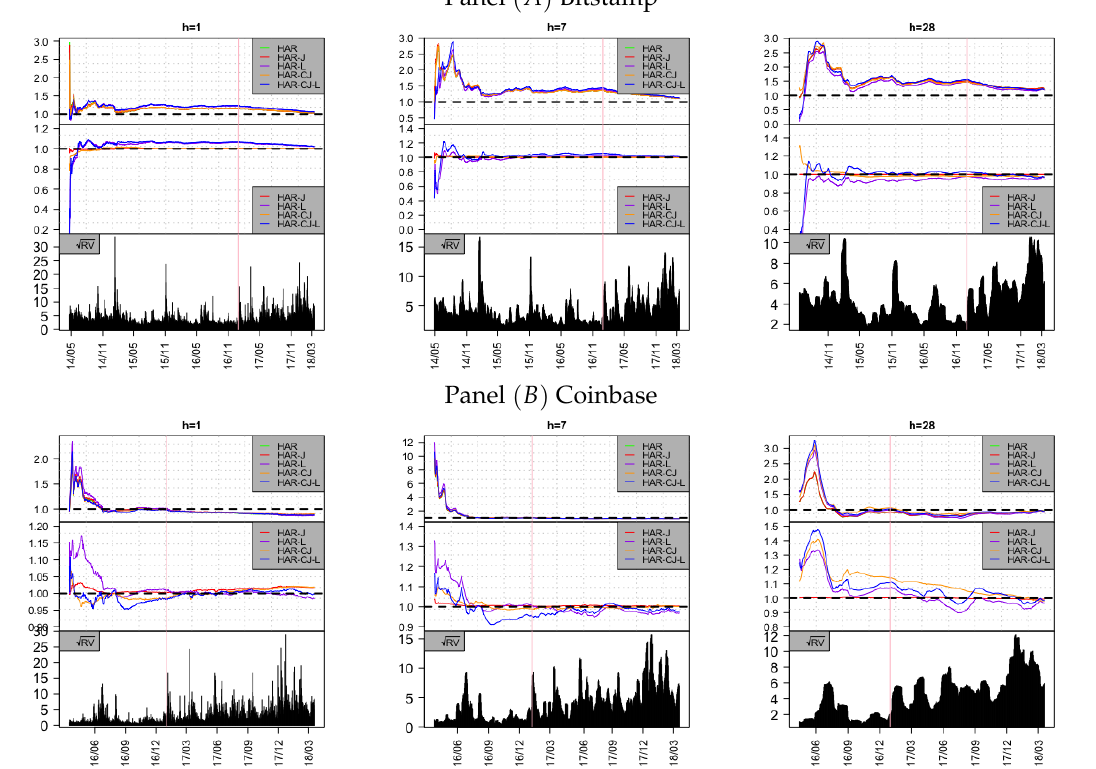
Figure 8. Relative cumulative absolute errors of several forecasting models with respect to RW (first sub-figure) and HAR-RV (second sub-figure). The third sub-figure reports the evolution of the realized standard deviation over time. The red vertical lines correspond to the start of the Hype period. Results are reported for Bitstamp in panel ( A ) and for Coinbase in panel ( B ) for the three forecast horizons h = 1, h = 7, and h =